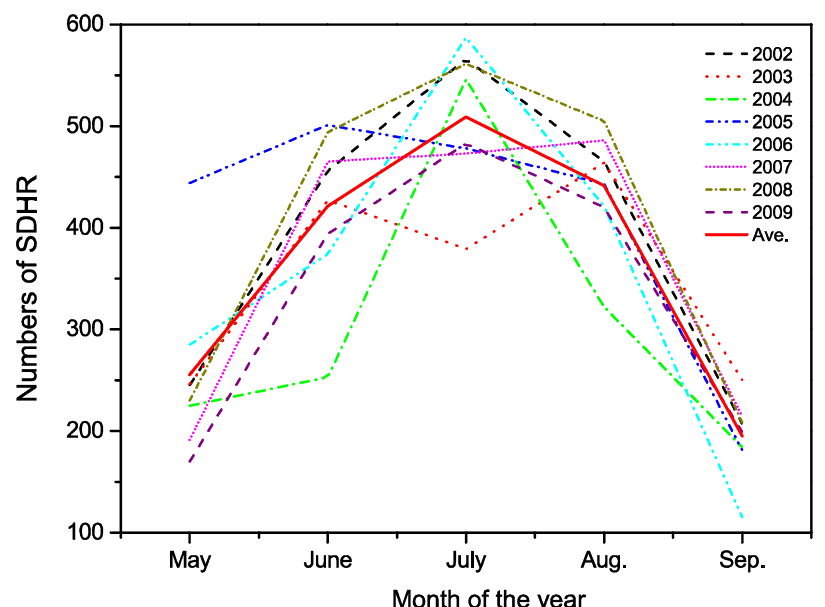
Figure 2. Monthly variation of the number of SDHR during the warm seasons of eight years. The bold solid red line represents the variation of the monthly average SDHR.